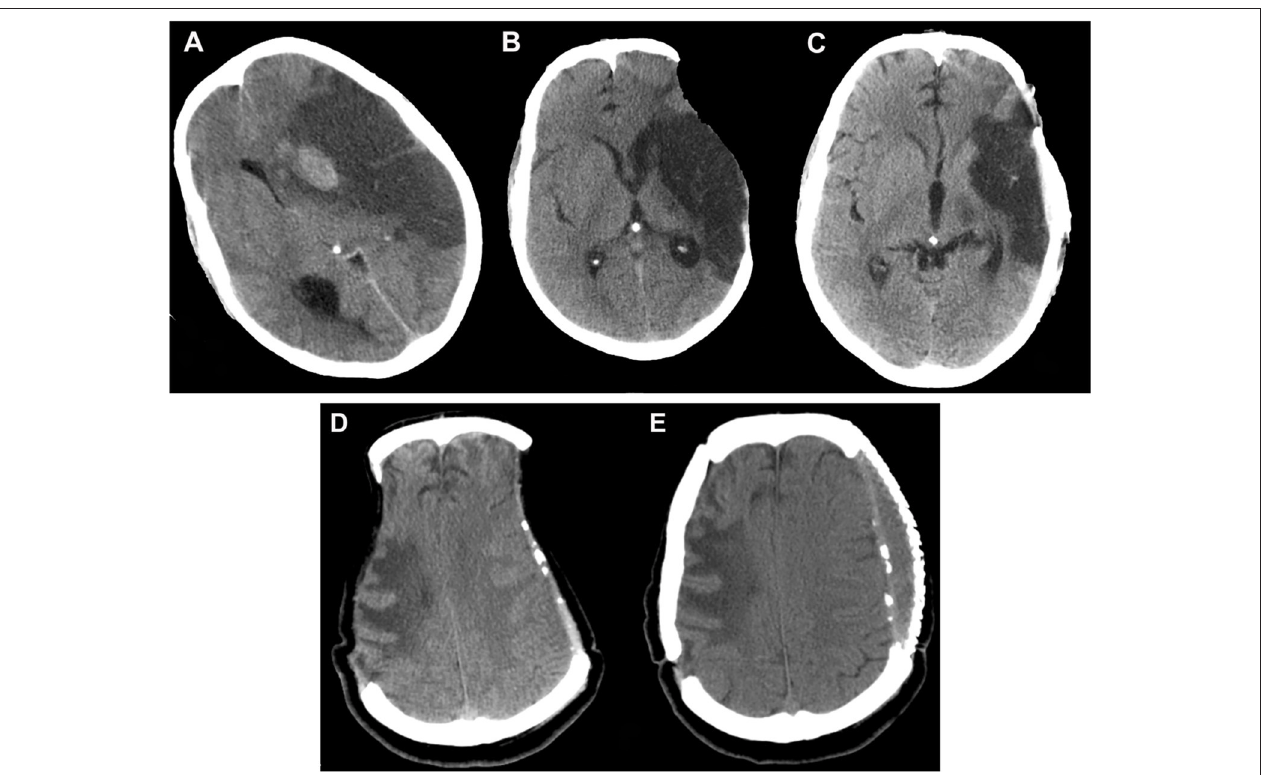
FIGURE 6 | Sunken flap syndrome. Computed tomography depicting (A) malignant hemispheric infarction, (B) sunken flap syndrome after 6 months, which improved (C) post cranioplasty. In a different patient (D) , bilateral sunken flap syndrome was observed 25 months post DC, and (E) improved after cranioplasty. DC, decompressive